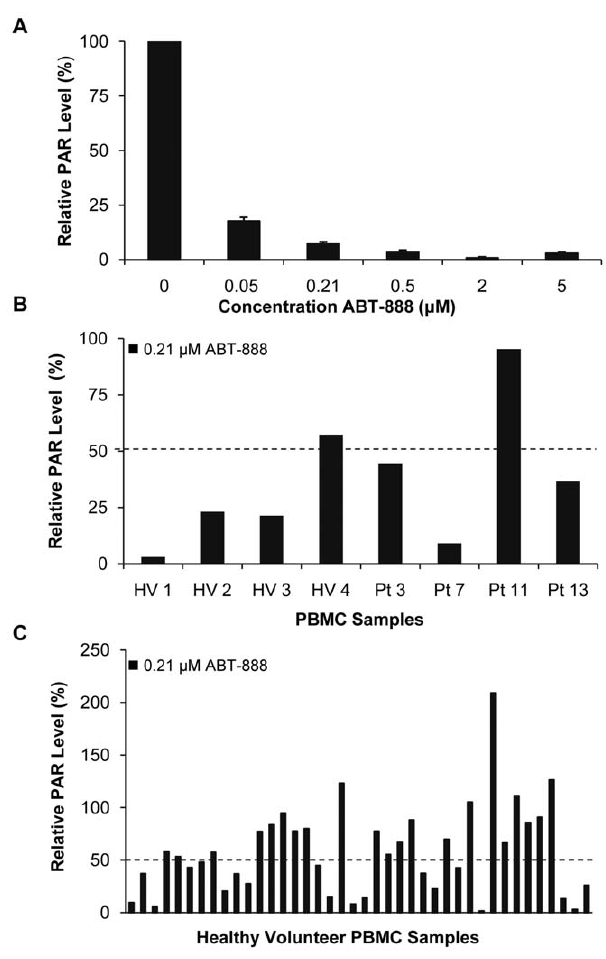
Figure 3. PBMC PAR levels in healthy volunteers and patients with cancer after ex vivo ABT-888 treatment. (A) Pooled PBMCs from healthy volunteers were treated ex vivo for 2 h with increasing concentrations of ABT-888. PAR levels were then determined by PAR immunoassay and normalized (100%) to the vehicle-treated control. Error bars represent standard deviations from three separate experiments. PAR levels were compared between (B) PBMCs from four healthy volunteers (HV) and four patients (Pt) with cancer and (C) 40 individual healthy volunteers. PBMC samples were treated ex vivo with 0.21 m M ABT-888 (the target clinical exposure) for 2 h and PAR levels are reported relative to vehicle-treated controls (100%). Dashed line, 50% reduction.